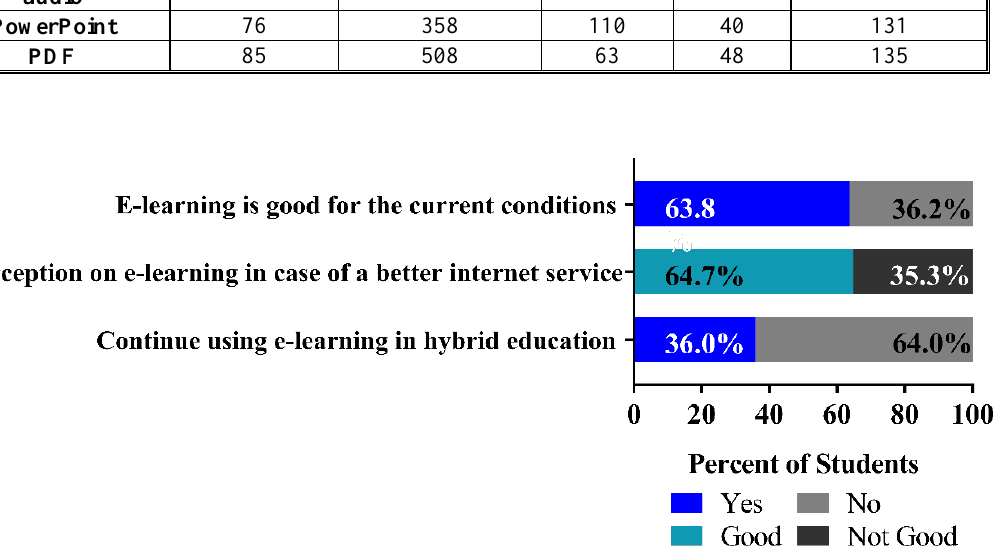
Figure 1. Students’ perception about e-learning experience after the first semester and before starting the second